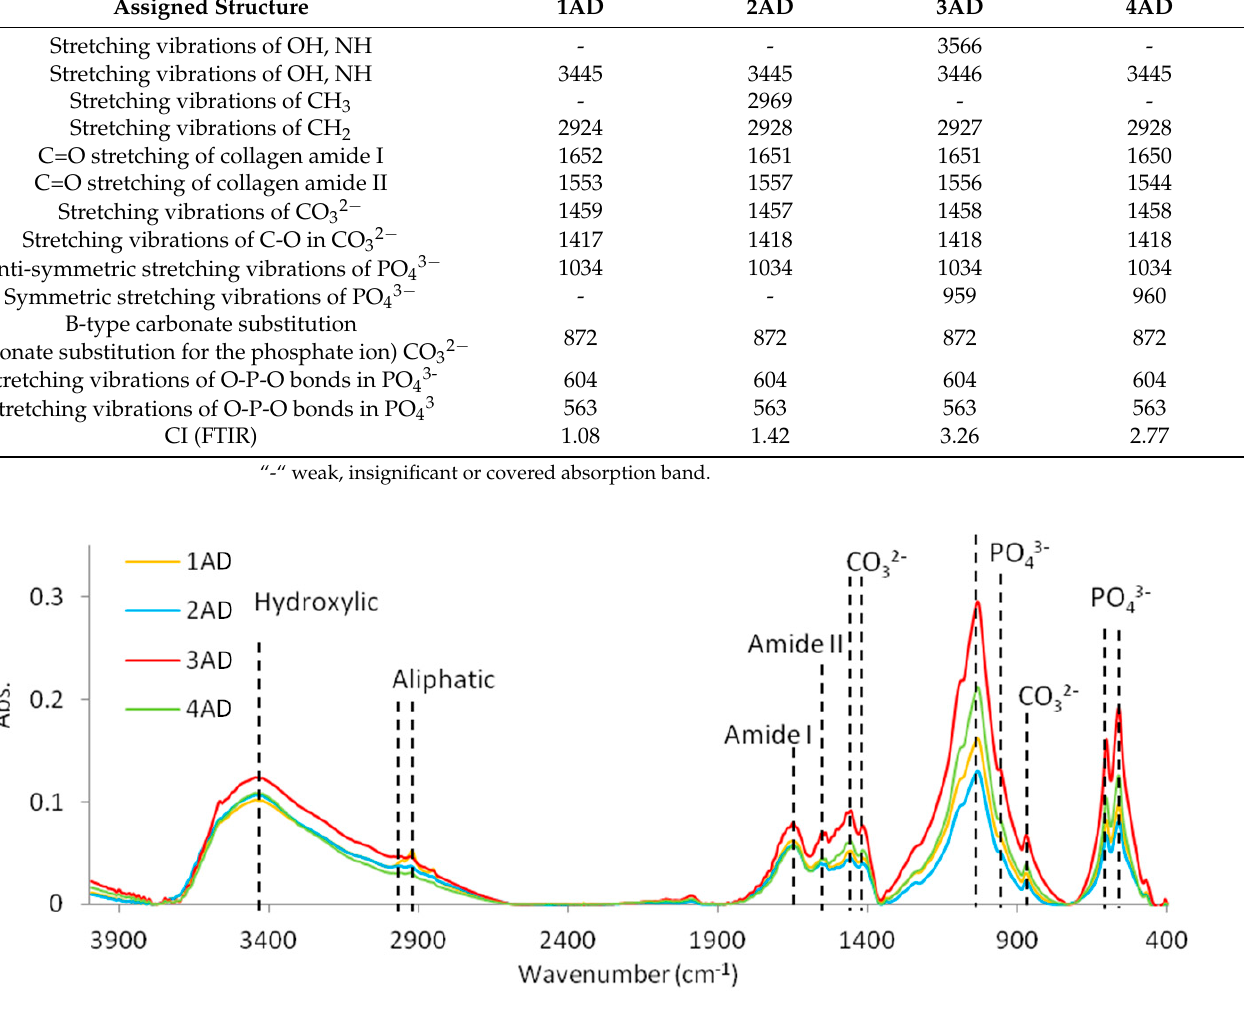
Figure 1. FTIR spectra of the different types of teeth (1AD-incisors, 2AD-canines, 3AD-premolars, 4AD-molars). Dashed lines indicate the main absorption bands associated with the vibration of the most important chemical groups. Table 1. Frequencies of the characteristic FTIR bands of different types of teeth.